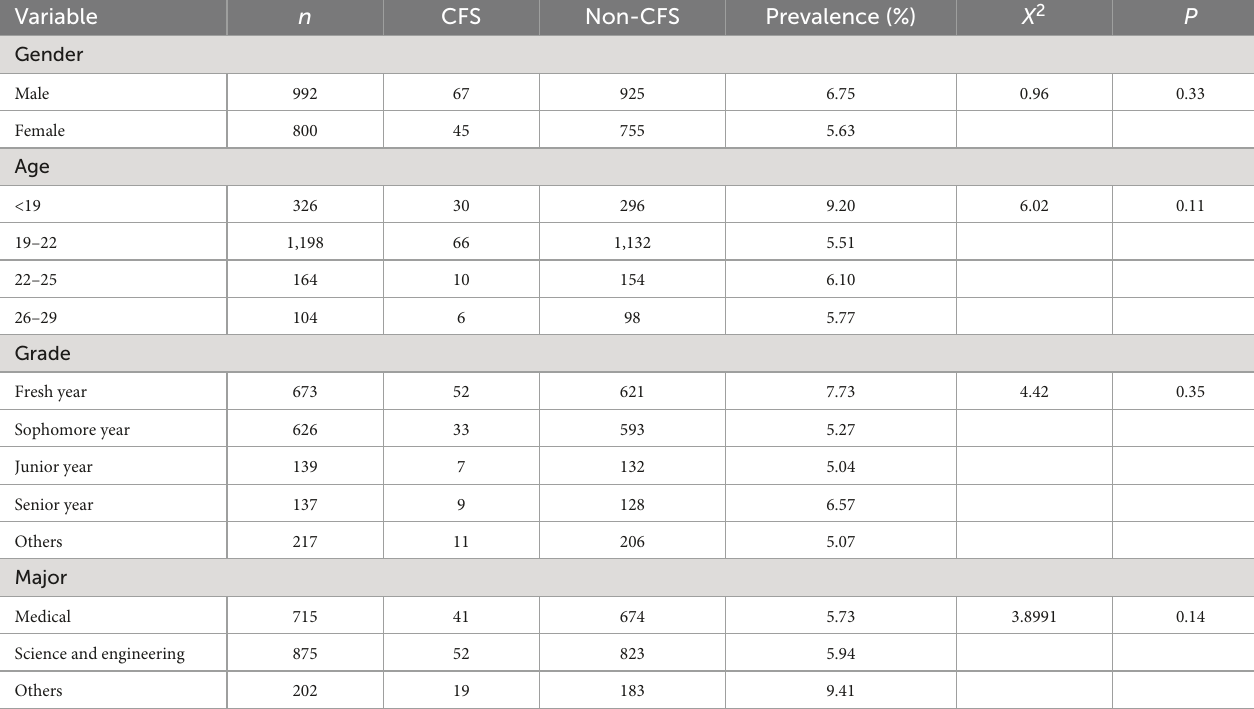
TABLE 1 Prevalence and characteristics of